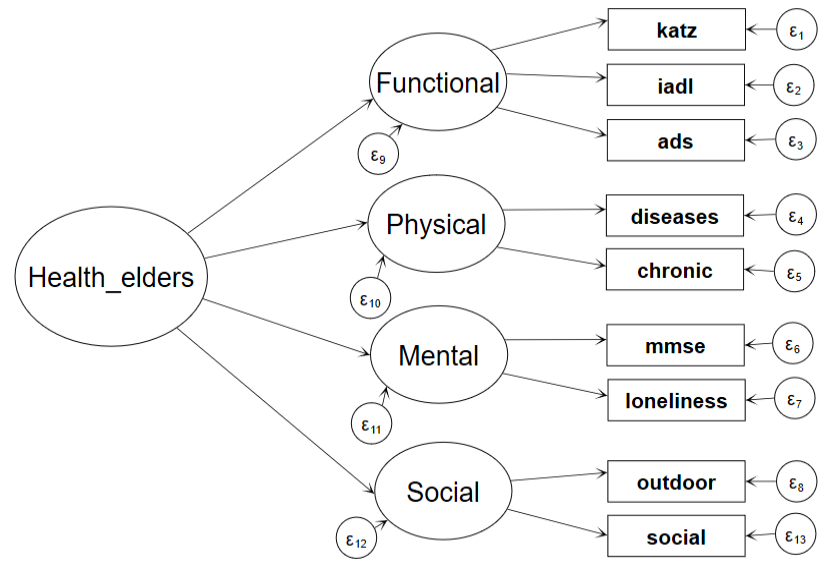
Figure 1. Theoretical Two-Order Factor Model.